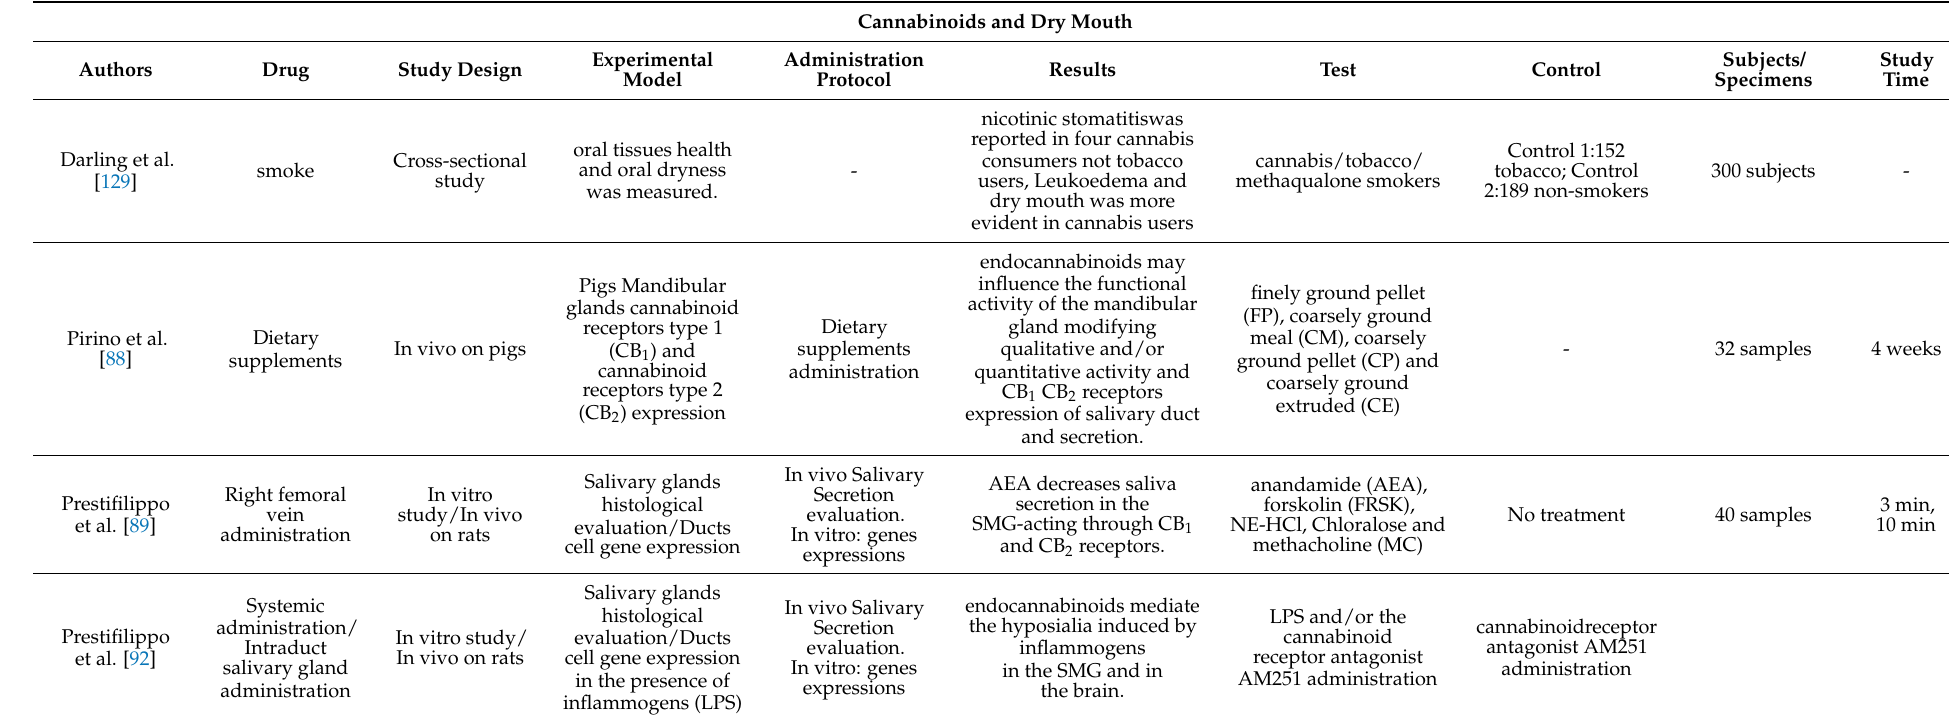
Table 3. Summary of the studies included according to the cannabinoids and dry